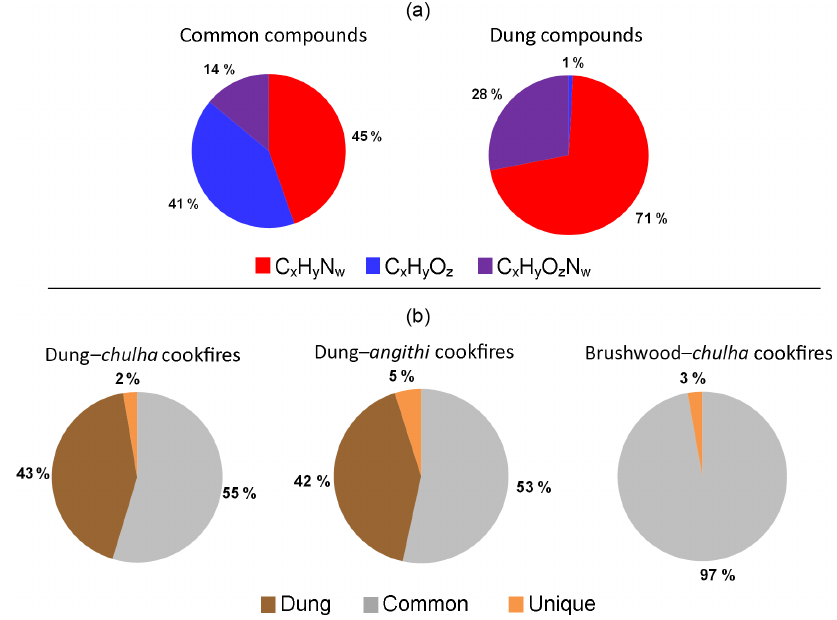
Figure 4. A summary of the inventory in terms of the count-based, normalized peak abundances. (a) Contribution of PM 2 . 5 compounds to each elemental formula category for those found in all cook fires and those found in all dung-burning cook fires. (b) The compounds by cookstove type classified as compounds common to all cook fires in grey, compounds common to all dung cook fires in brown, and unique compounds in